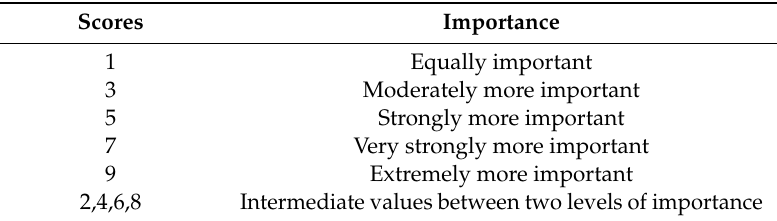
Table 2. The scoring scheme used for generating pairwise comparison matrices in the analytic hierarchy process (AHP)